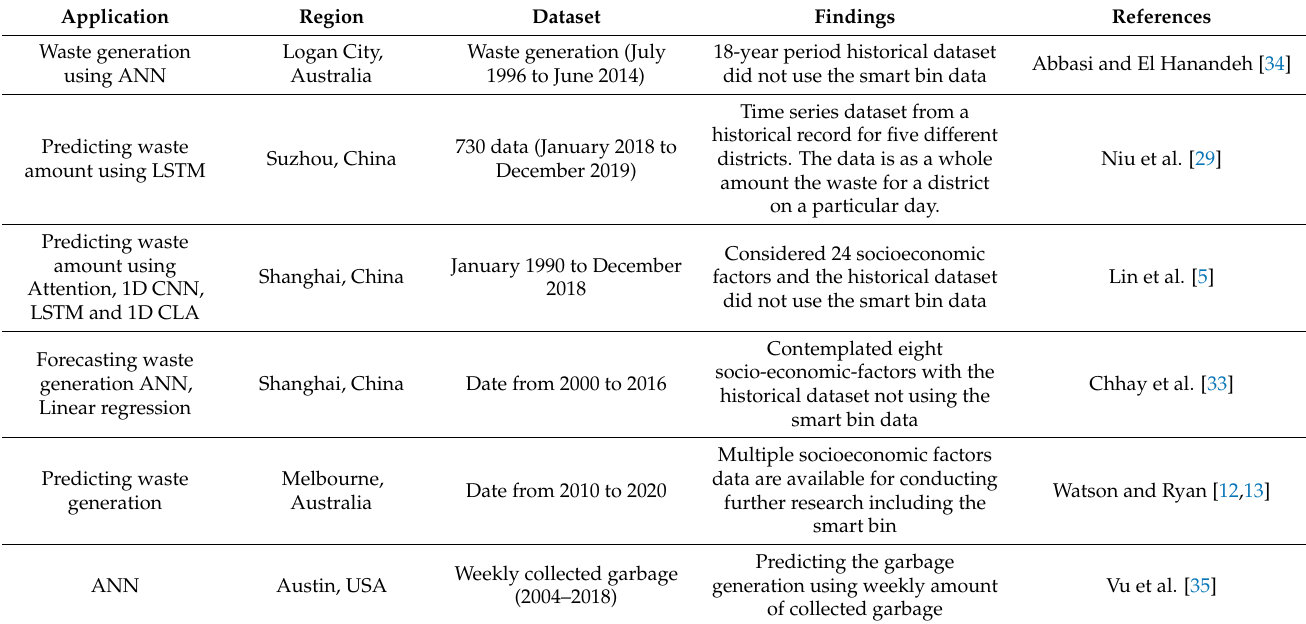
Table 1. Application of deep–learning models in waste generation